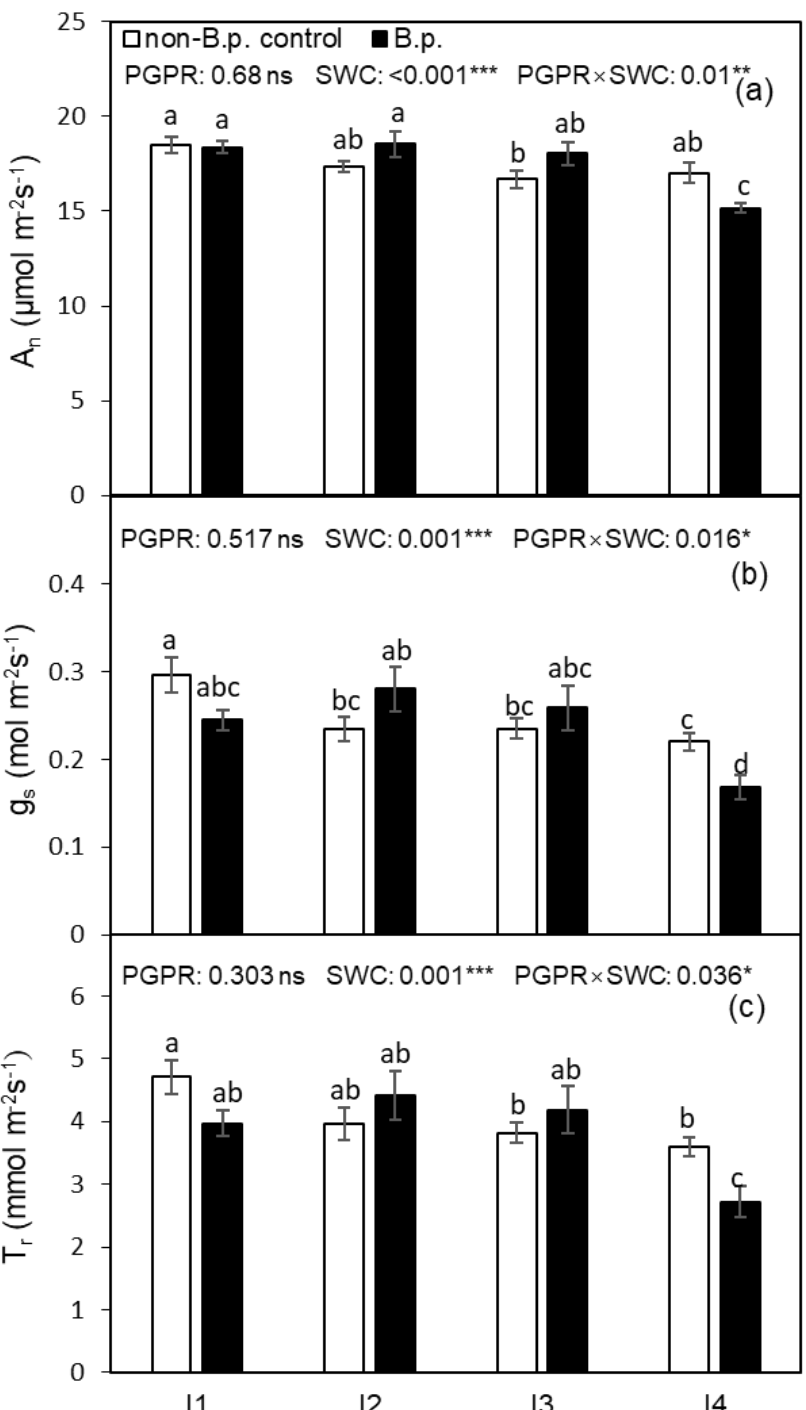
Figure 1. Photosynthesis rate (A n ), stomatal conductance (g s ), and transpiration rate (T r ) of tomato leaf as affected by PGPR inoculation under four irrigation regimes (I1—irrigated to 35% ( v / v ) SWC; I2—irrigated to 30% SWC; I3—irrigated to 25% SWC; and I4—irrigated to 20% SWC). Different letters indicate a significant difference among treatments based on Tukey’s honestly significant different test after Two-way ANOVA. Error bars indicate the standard error of the means (SE), n = 4. ( a – c ) in the figure are corresponding to A n , g s and T r , respectively. ns indicates the effect was not statistically significant at p < 0.05 level; *, ** and *** indicate significance levels at p < 0.05, p < 0.01 and p < 0.001, respectively.